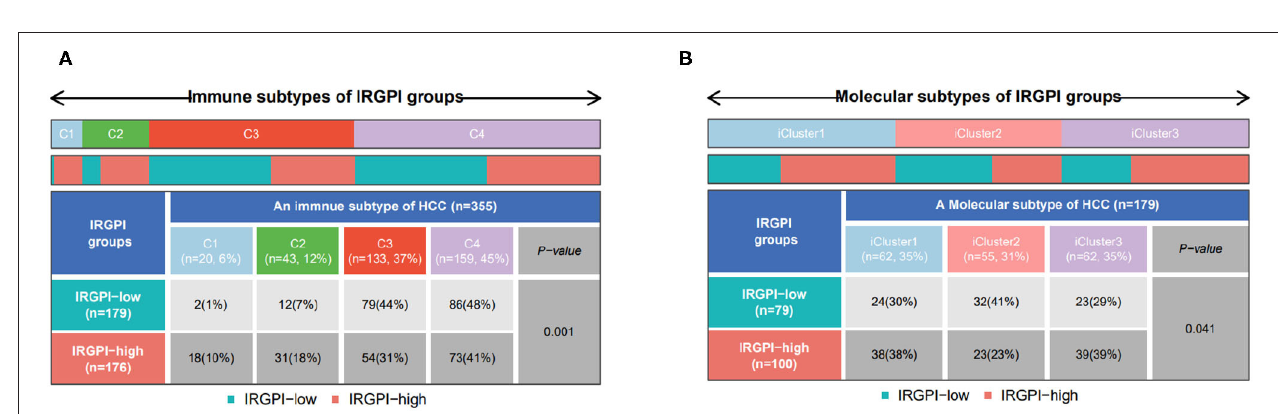
FIGURE 6 | Scatter plots coordinated by IRGPI risk score and other immune biomarkers, and (A–F) represents PD-L1, PD-1, PD-L2, CTLA-4, CYT, and TMB, respectively.